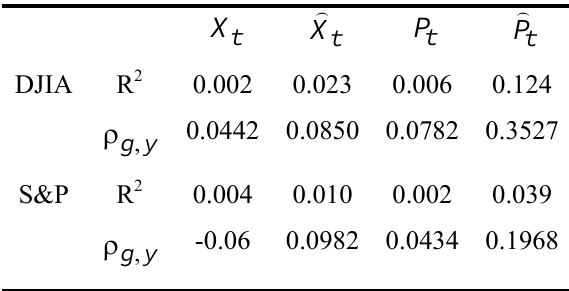
Table 2 Correlations with Output